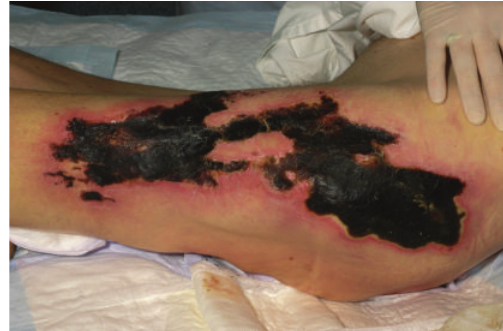
Figure 2: Large CUA lesion of the proximal lower limb with necrotic